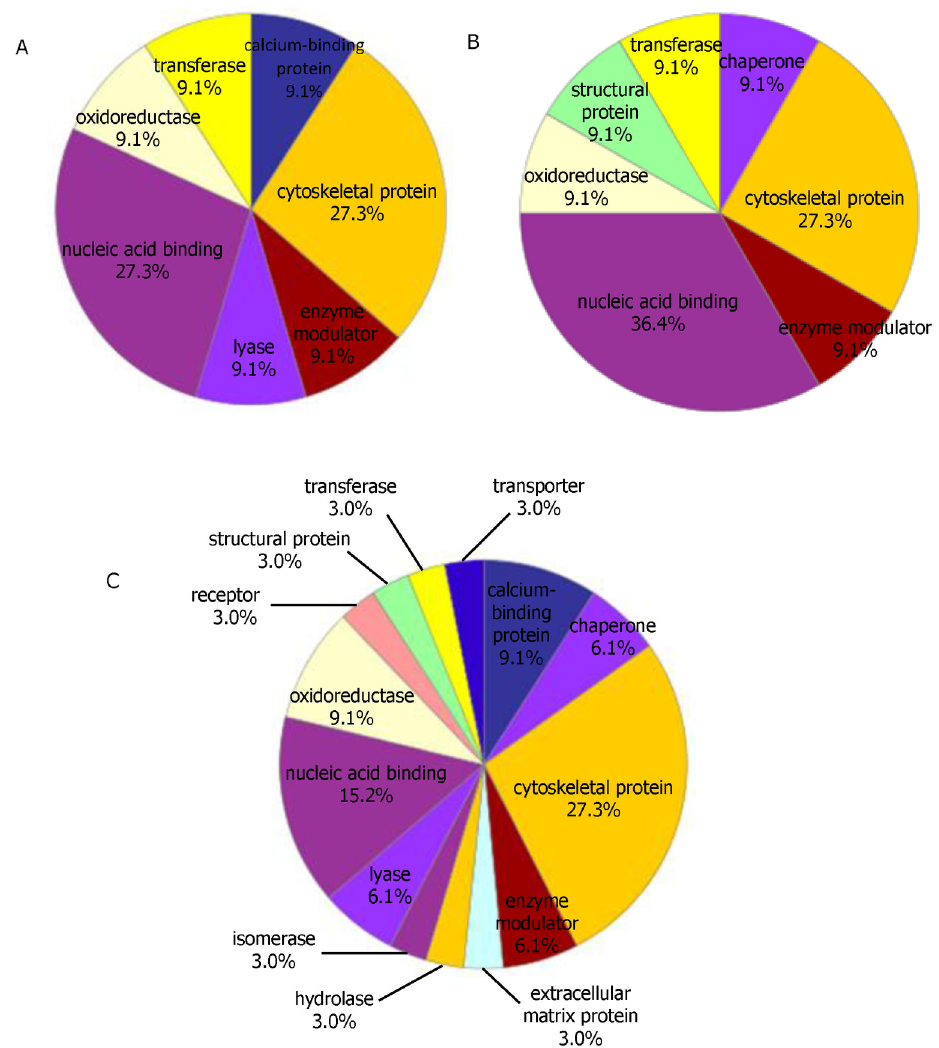
Fig 2. Functional classifications of the identified proteins according to their protein classes of 24h (A), 48h (B) and 72h (C) by